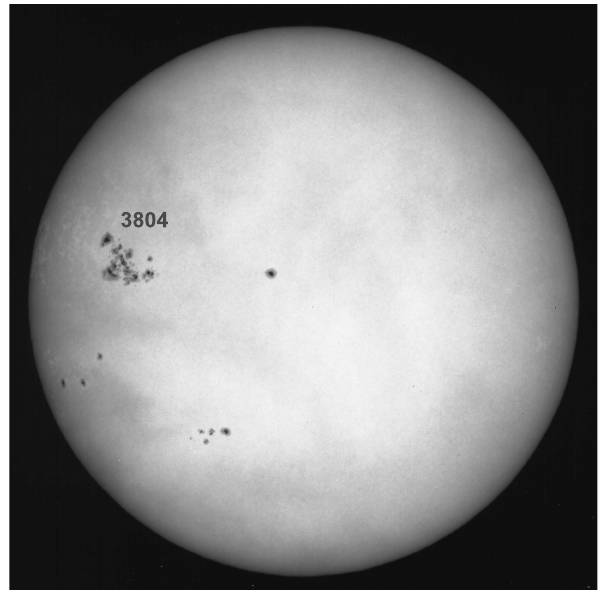
Fig. 3. White-light full disc image of the Sun at 09:18UT on 12 July 1982 from the National Astronomical Observatory of Japan,